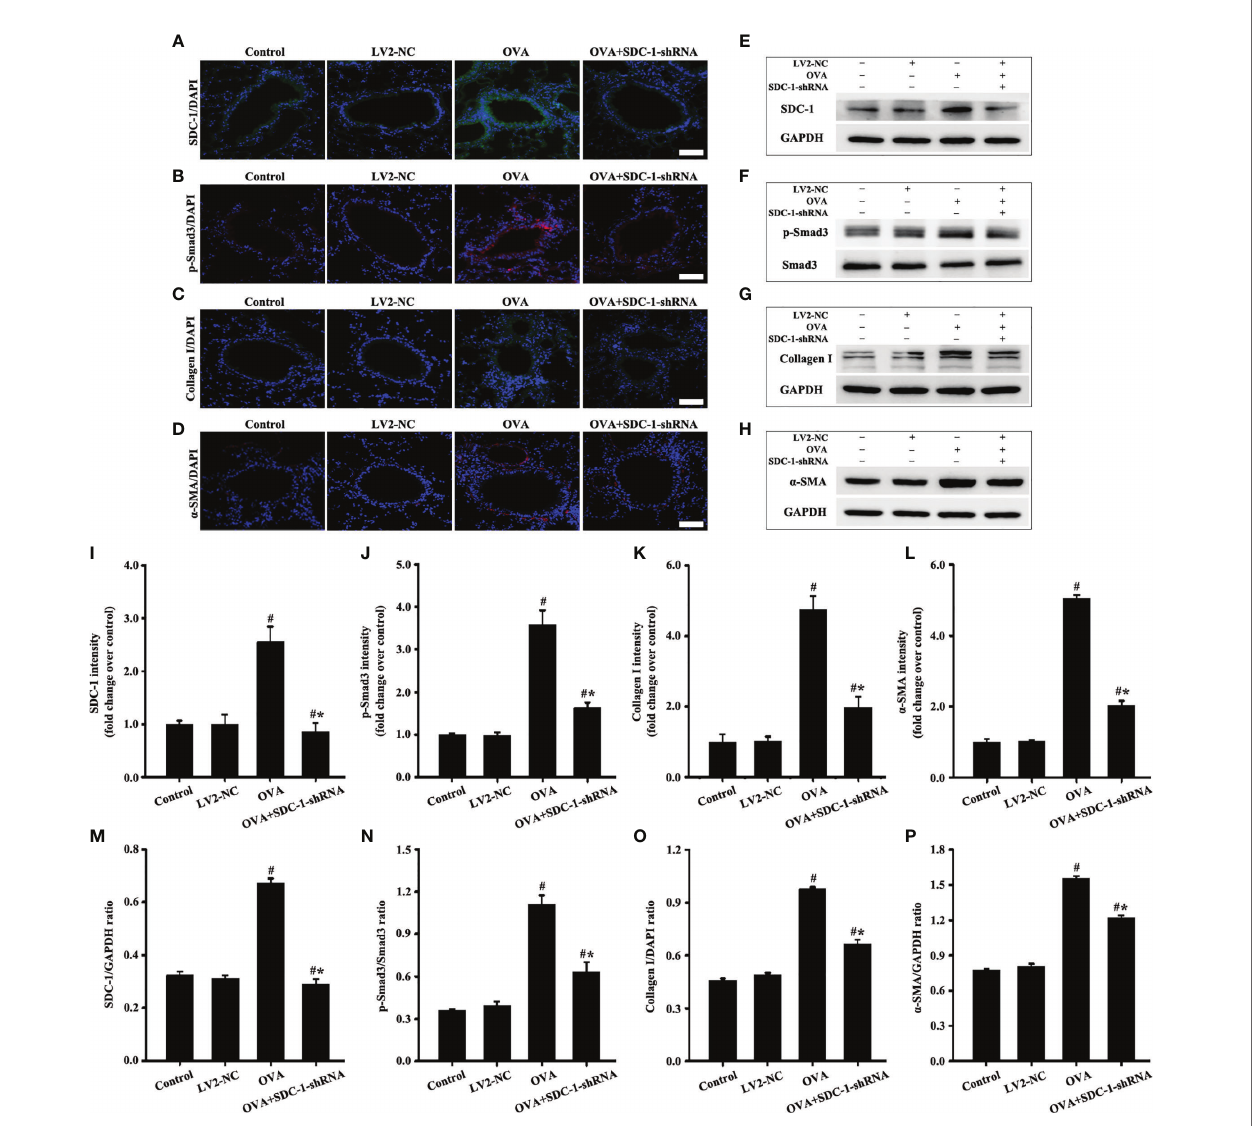
FIGURE 9 | Animal experimental intervention schedule is shown in Figures 8A1, A3 . Effects of SDC-1 deletion by SDC-1 shRNA on the levels of SDC-1 (A , E) , p-Smad3 (B , F) , collagen I (C , G) , and a -SMA (D , H) in mice were observed by immuno fl uorescence and Western blot. (I – L) Immuno fl uorescence intensity analysis of (A – D) , respectively. (M – P) Gray intensity analysis of (E – H) , respectively. Data are shown as the means ± SD of three independent experiments. # p < 0.05 versus the control group. # *p < 0.05 versus the OVA